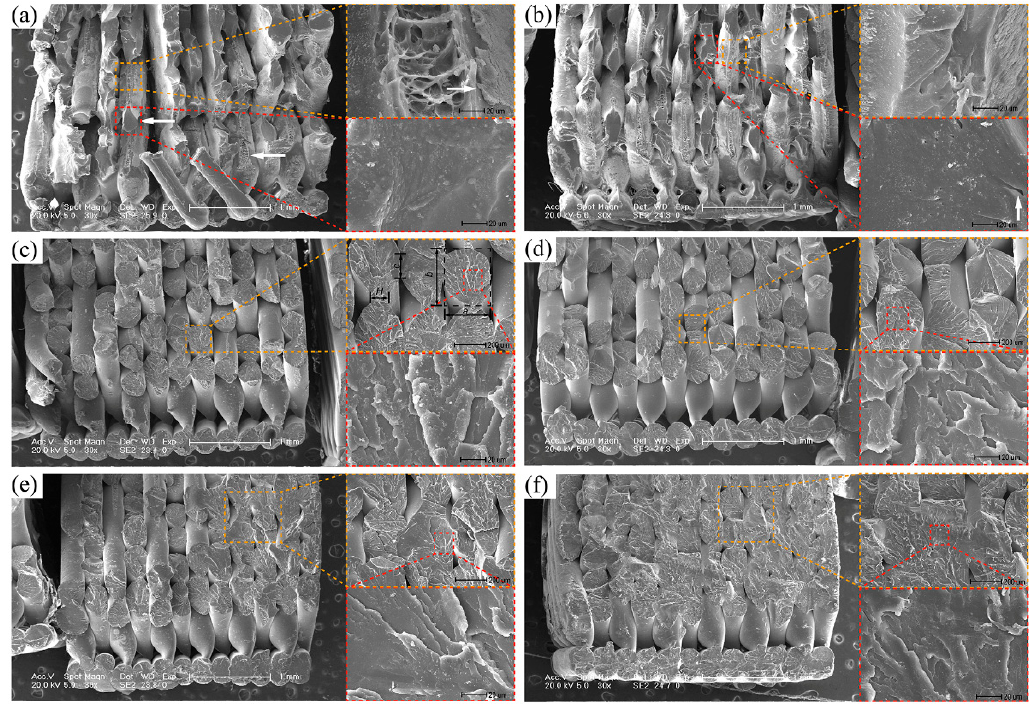
Figure 9. SEM micrographs of the fracture of 3D-printed PPS tensile samples under different thermal conditions: ( a ) air-forced cooling; ( b ) natural cooling; ( c ) 130 ° C; ( d ) 150 ° C; ( e ) 200 ° C; ( f ) 240 ° C.